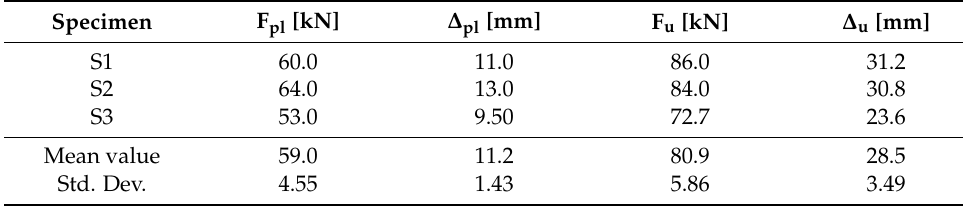
Table 1. Characterization of experimental load–piston displacement